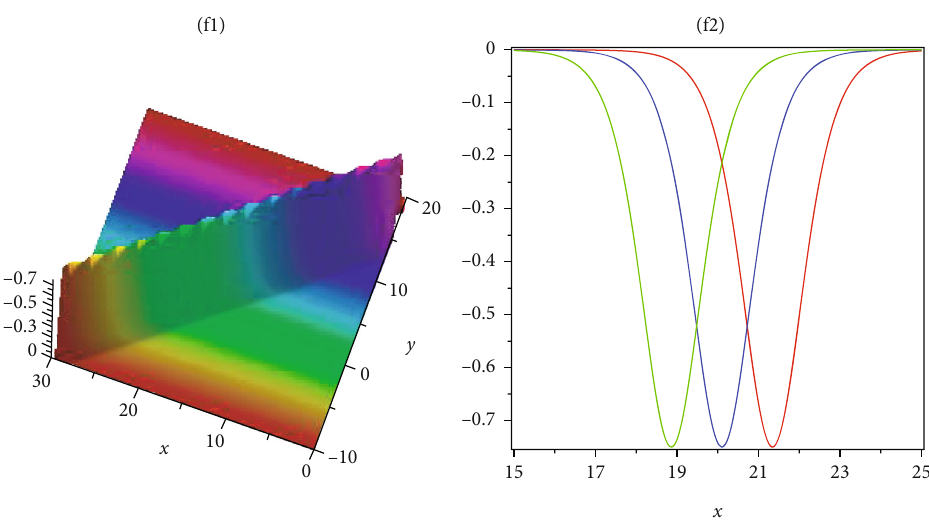
Figure 5: Graph of Eq. (36) for the ( 2 + 1 )-dimensional Benjamin-Ono equation at a = 2, α = 2, β = − 3, c = 2, γ = 2, r = 1, w = 0 : 3, d = 2, δ = − 2, z = 1, t = 20 and for 2 plot spaces y = − 1, 0, 1 .